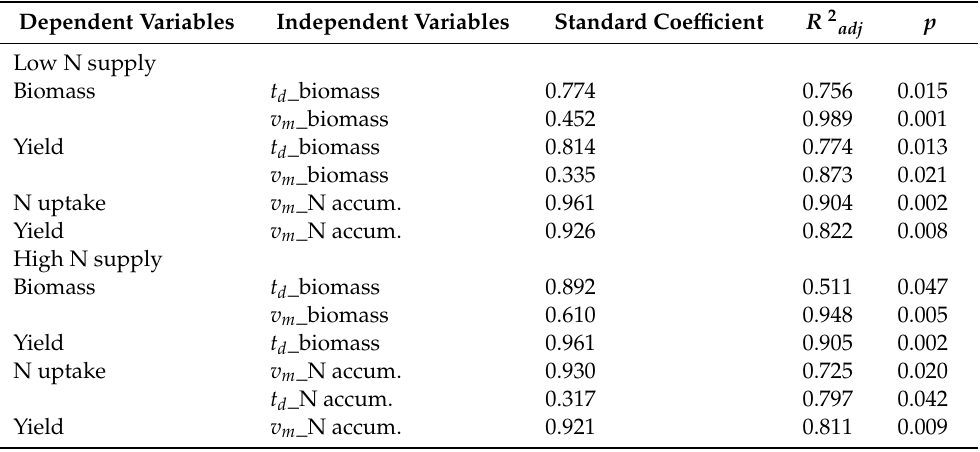
Table 6. Stepwise multiple analysis for the determinants of crop biomass, yield and N uptake yield in three oilseed rape cultivars under low and high N supply during the 2014–2015 and 2015–2016